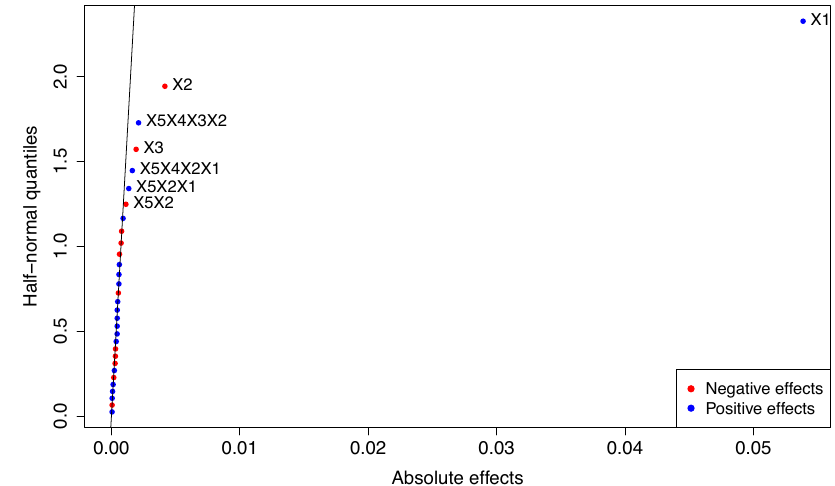
Fig. 1 Half-normal plot of all effects, where input factors ( P A , λ , μ , γ , − d γ /d T ), are represented by ( X 1 , X 2 , X 3 , X 4 , X 5 ), respectively. The X-axis represents the absolute value of the effects, and the Y-axis shows the corresponding probability of observing such an effect. Only the outliers (i.e. signi fi cant effects) are labeled on the